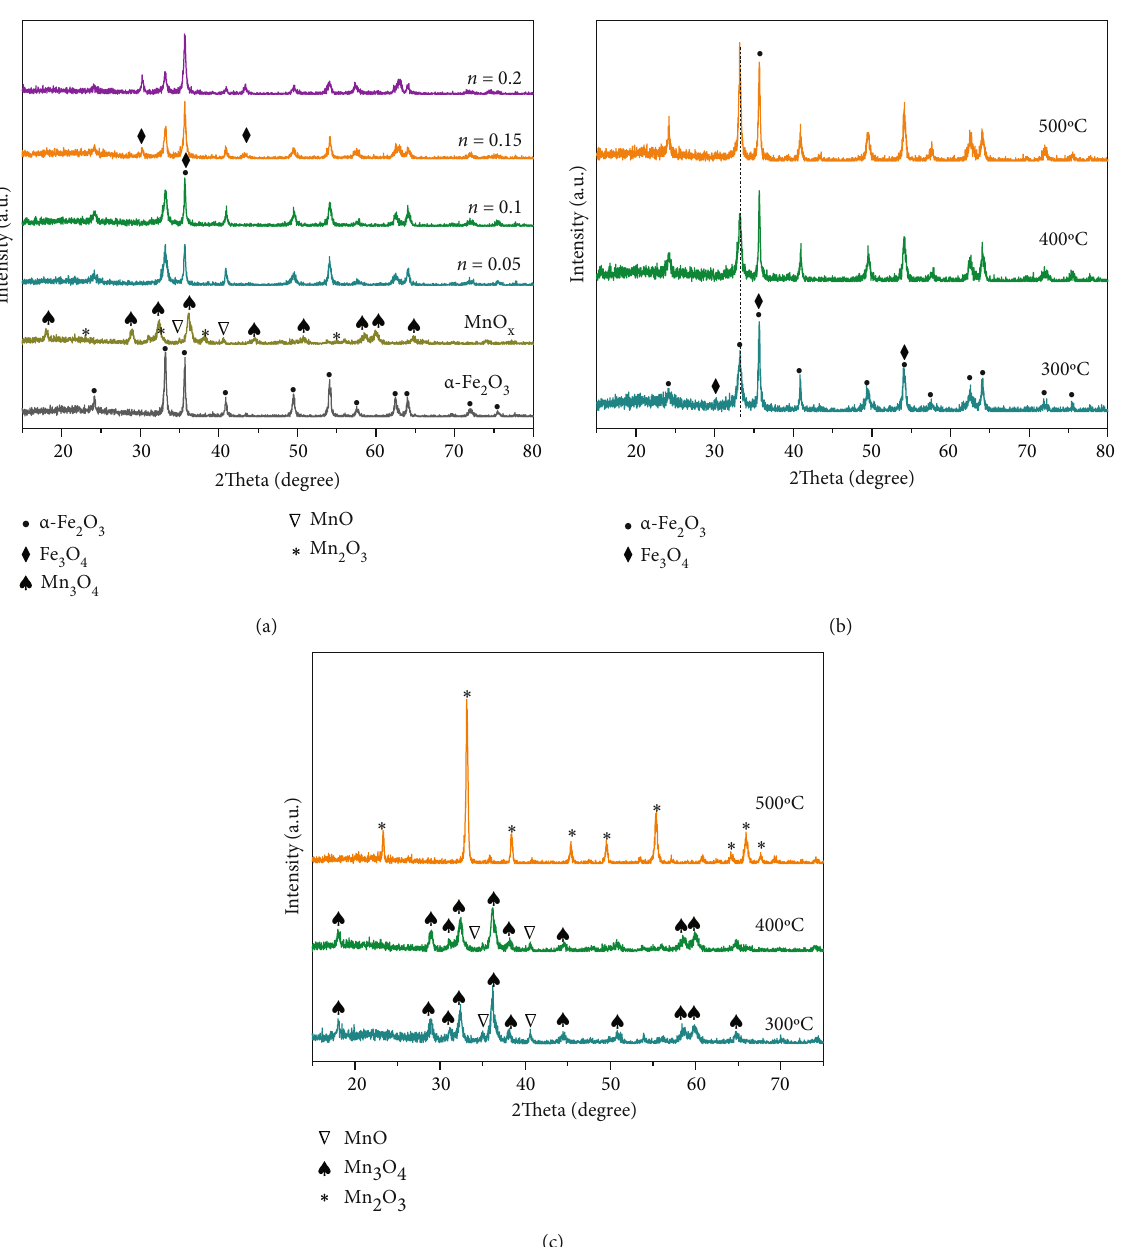
Figure 3: XRD patterns of (a) samples with di ff erent molar ratios, (b) MnO